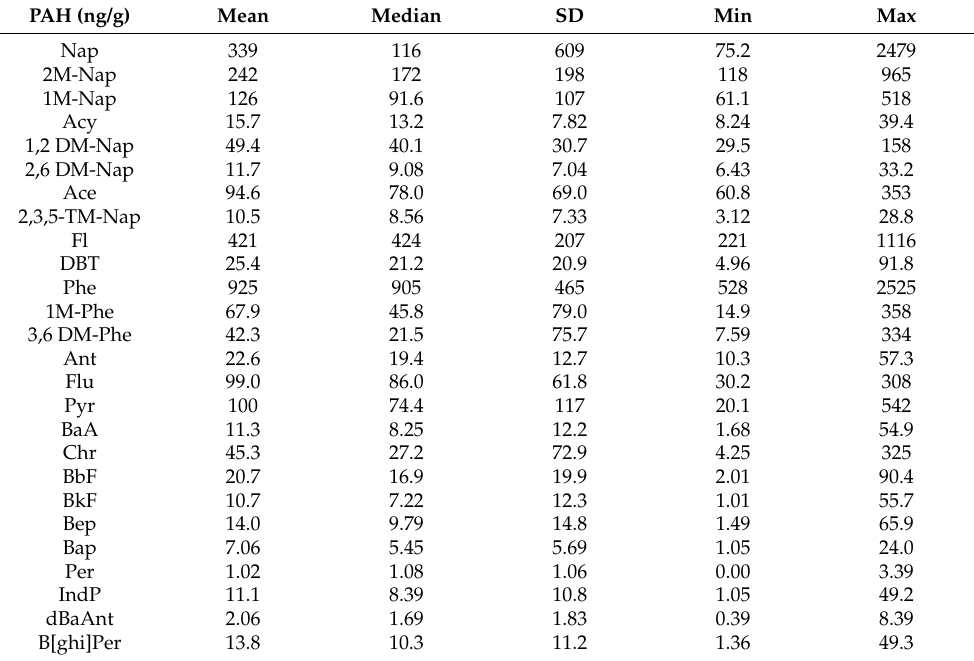
Table 1. Concentrations of polycyclic aromatic hydrocarbons (PAHs) in indoor dust samples (ng/g). PAH (ng/g) Mean